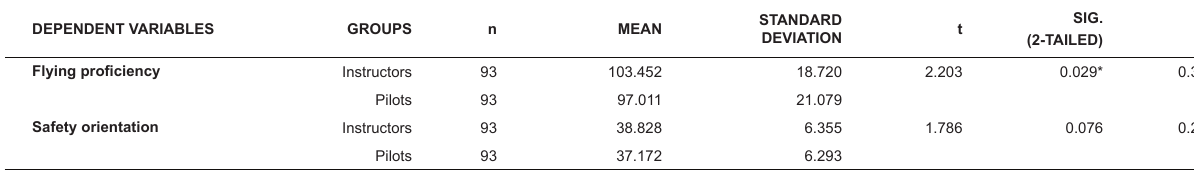
TABLE 3 T-test comparison of the mean scores of instructors’ and pilots’ perceptions of gender-related pilot behaviour